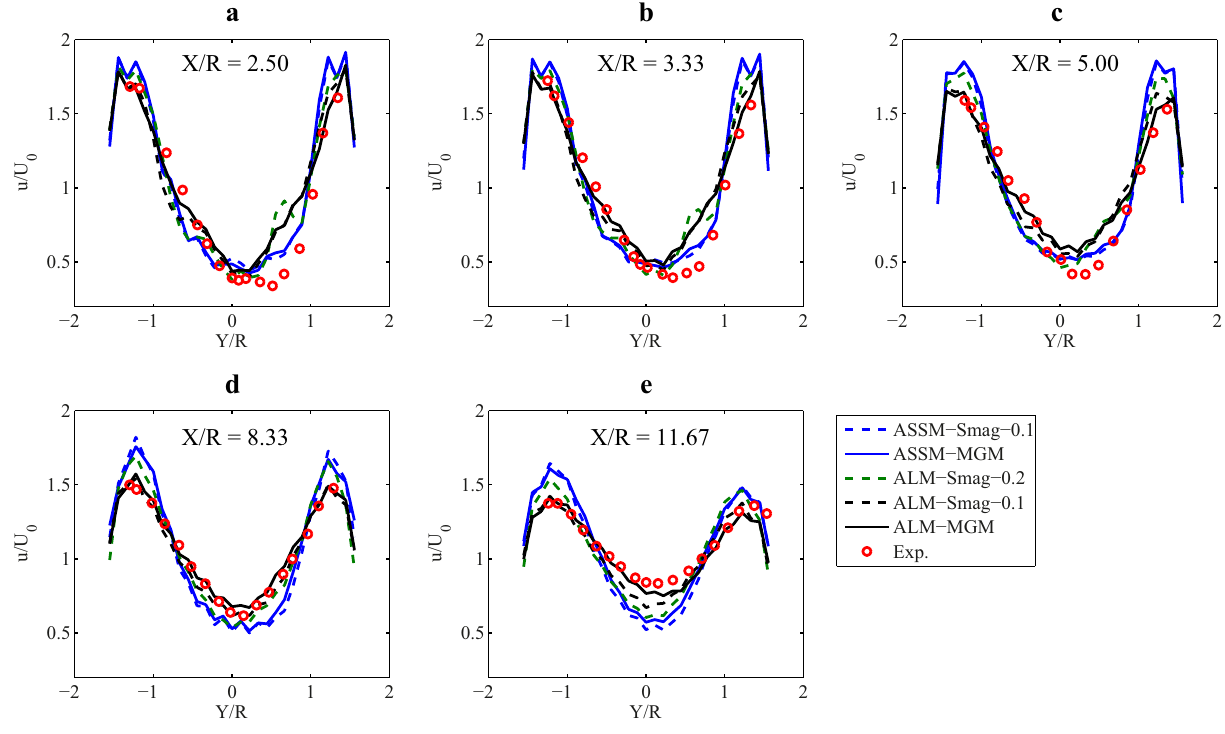
Figure 11. Comparison of the spanwise profiles of the normalized mean streamwise velocity, u/U , at different downstream locations: ( a ) x/R = 2 . 50 ; ( b ) x/R = 3 . 33 ; ( c ) x/R = 5 . 0 ; 0 ( d ) x/R = 8 . 33 ; ( e ) x/R = 11 . 67 . Water channel measurements (red circles), ALM-MGM (solid black line), ALM-Smagorinsky C C = 0 . 2 (dashed green line), ASSM-MGM (solid blue line) and ASSM-Smagorinsky S C = 0 . 1 (dashed blue S